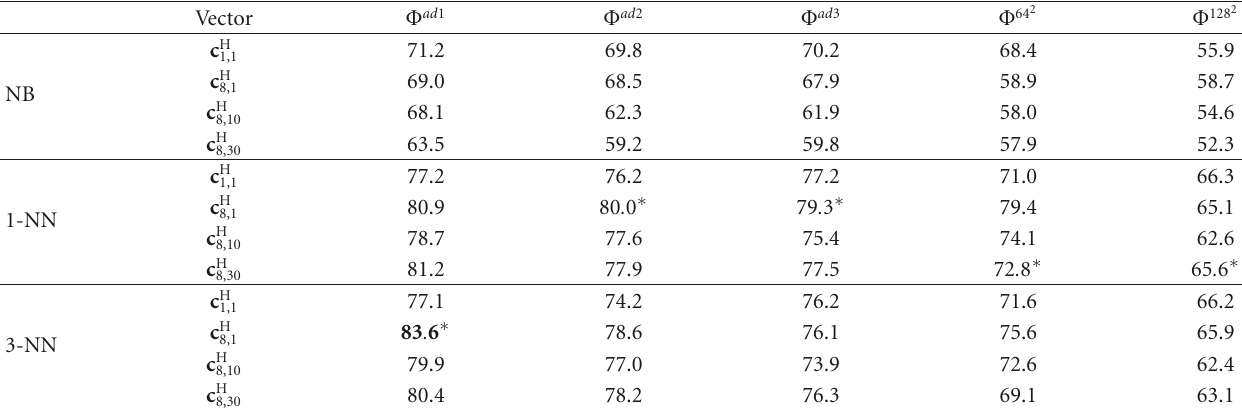
Table 5: Rate C P of correctly classified patterns for five image sets with Haralick’s textural features. The best rate C P for each image set is shown by an ∗ .